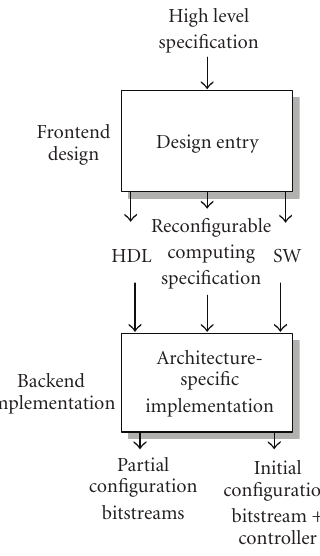
Figure 1: Combined design and implementation